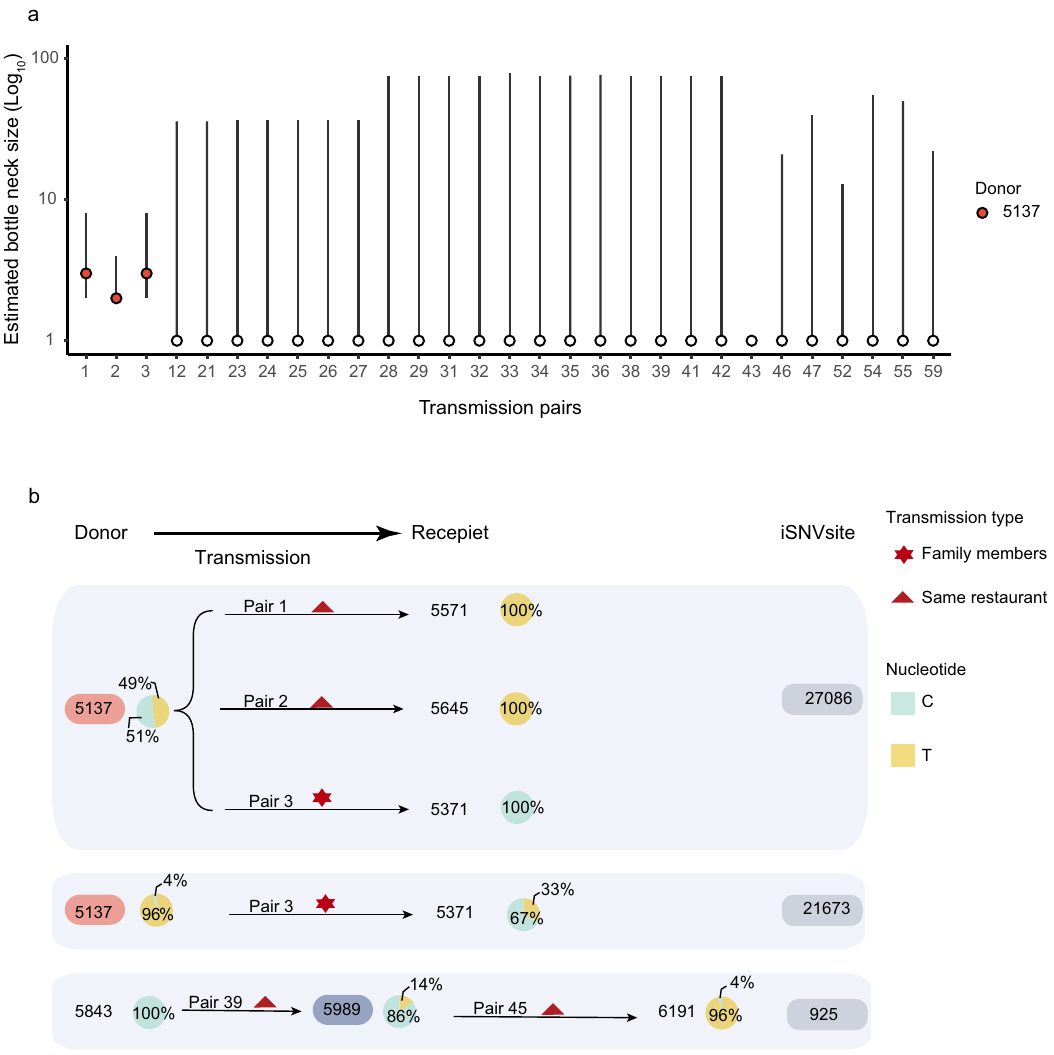
Fig. 3 Transmission bottleneck size and transmissions of intra-host variants in the outbreak. a Estimated bottleneck size in donor-recipient transmission pairs ( n = 29) was calculated using the exact beta-binomial method. Bars show mean and 95%CI, calculated using the likelihood ratio test. b Minor iSNVs transmission resulted in the diversity of viral population. The pie charts show the frequency of iSNVs. Arrows show the direction of transmission for those pairs of cases for which this is known with high con fi